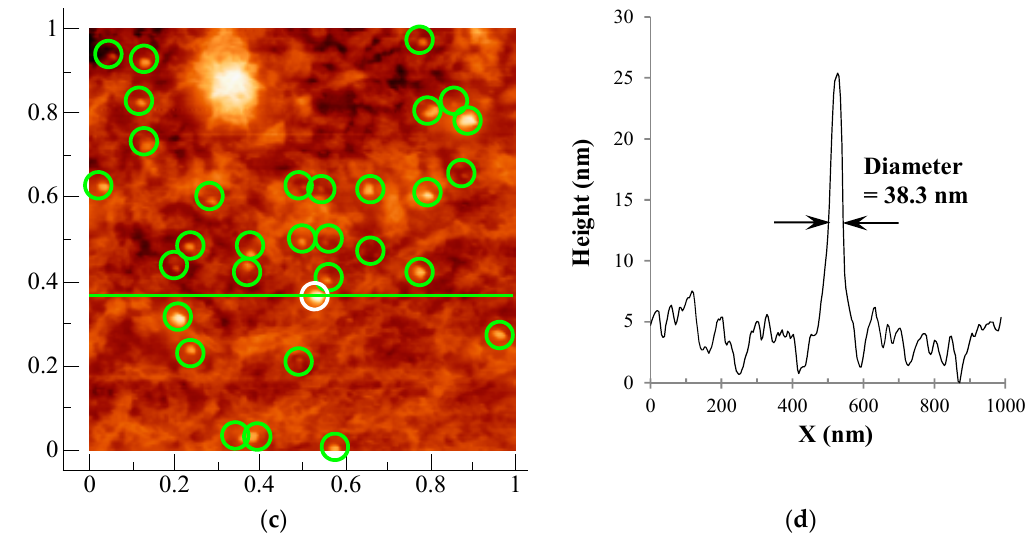
Figure 2. ( a ) Atomic force microscopy (AFM) image of hybrid cellulose film (1000 nm × 1000 nm) in topographic mode; ( b ) AFM image of hybrid cellulose film, the same as in ( a ) in phase mode; circles were drawn around the undoubtedly silver nanoparticles; ( c ) AFM image of ( a ) superposed with the same circles which were drawn in the phase image in ( b ); ( d ) Height profile for a horizontal line crossing the white circle center.